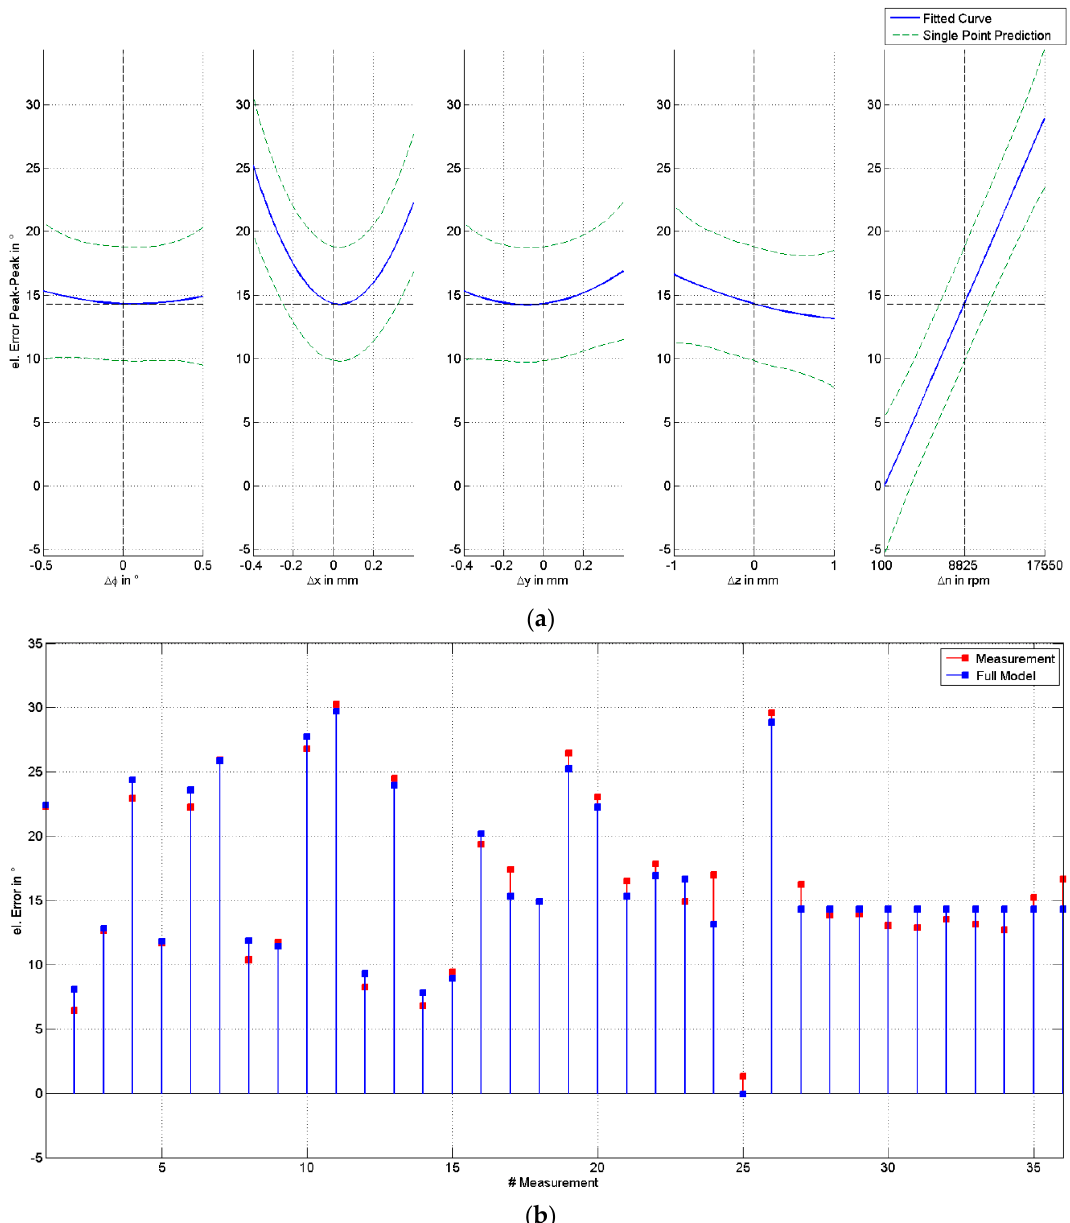
Figure 21. Result of the DoE sensor characterization based on the post processing signals (triggered reference angle and determined and compensated DUT resolver angle): ( a ) diagram representing the electrical angle error (peak–peak) in degrees over the five parameter variations ∆ x , ∆ y , ∆ z , ∆ φ and ∆ n ; ( b ) comparison of measurement and full quadratic model at the design points of the exemplary Central Composite Inscribed (CCI) design.